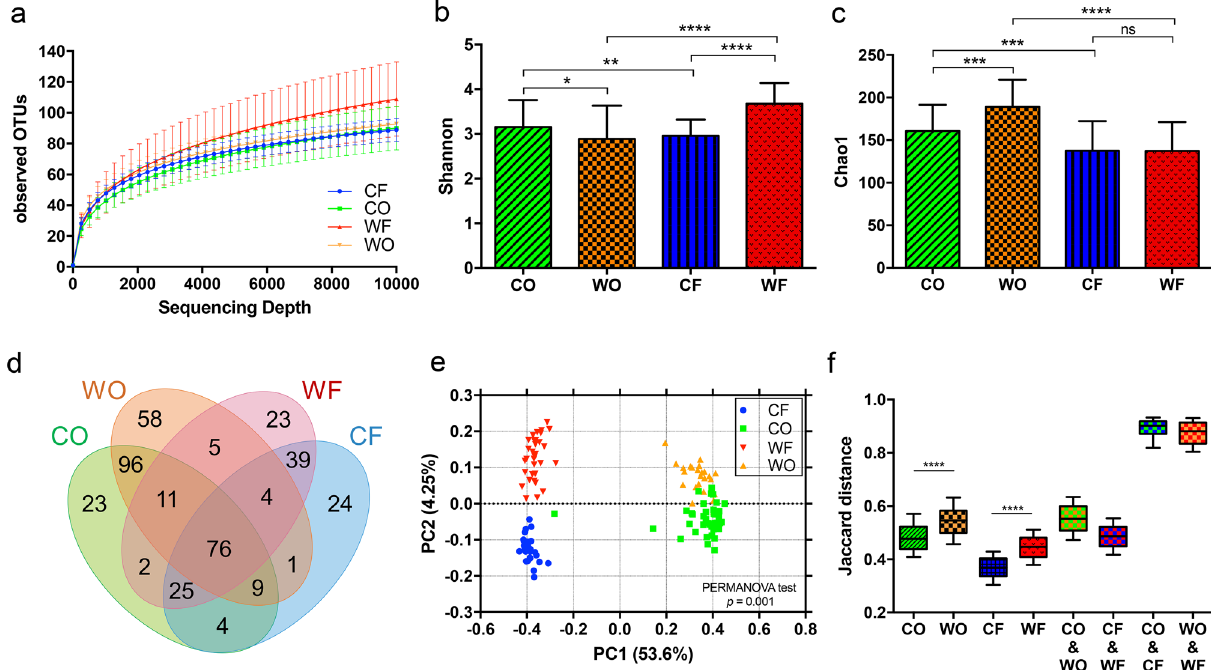
Figure 1. The bacterial diversity in oral-fecal microbiome of wild and captive long-tailed macaques. ( a ) Rarefaction curve indicated the observed OTUs (mean ± SD) against sequencing depth in each group: CO captive-oral, WO wild-oral, CF captive-fecal, WF wild-fecal. The alpha diversity was determined by two indices: ( b ) Shannon’s diversity index and ( c ) Chao1 index which were plotted by mean ± SD and statistically tested by Mann–Whitney U test (* P < 0.05, ** P < 0.01, *** P < 0.001, **** P < 0.0001, ns not significant). ( d ) The Venn diagram showed the numbers of shared taxa among groups. ( e ) The beta diversity was plotted in principal coordinate analysis (PCoA) plots based on Jaccard dissimilarity (tested by PERMANOVA analysis). ( f ) The box plot represented the Jaccard distances between communities which were statistically tested by Mann–Whitney U